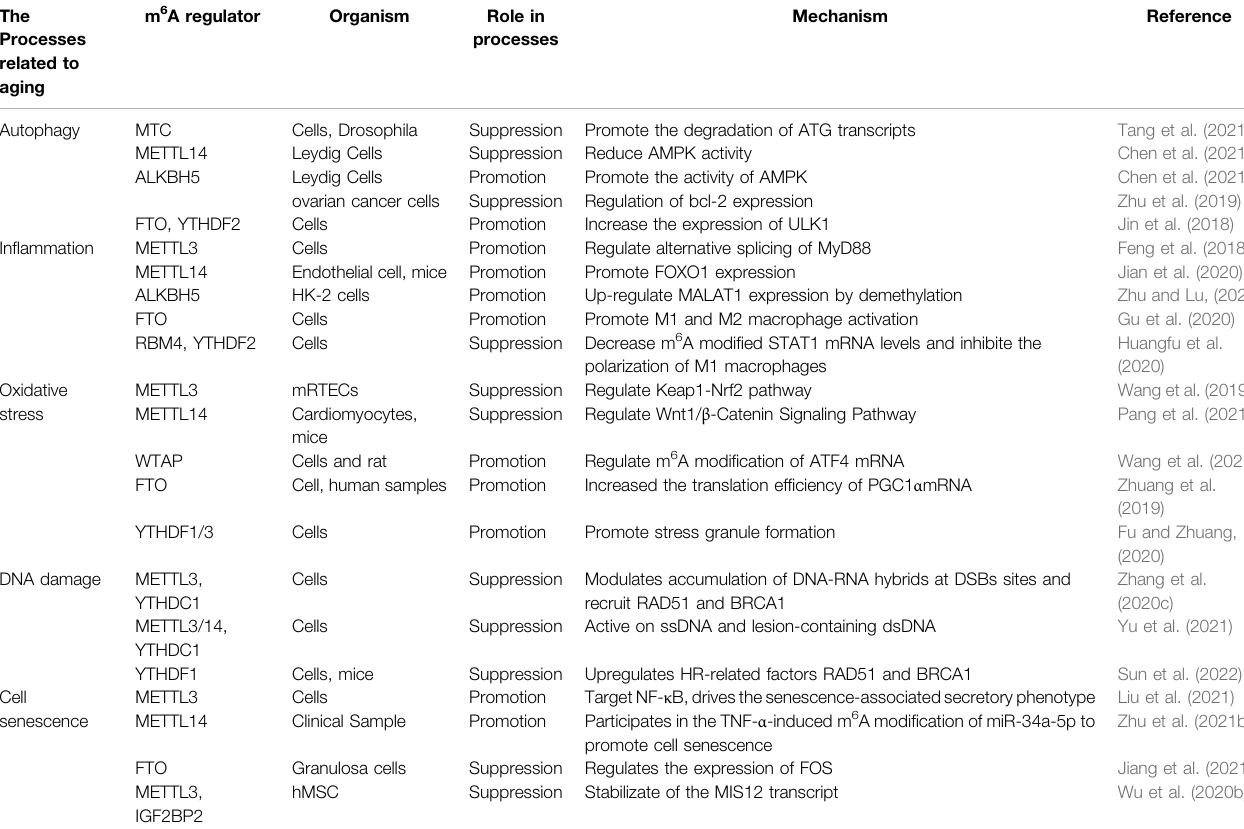
TABLE 1 | The role of m 6 A modi fi cation in the fundamental processes. The Processes related to